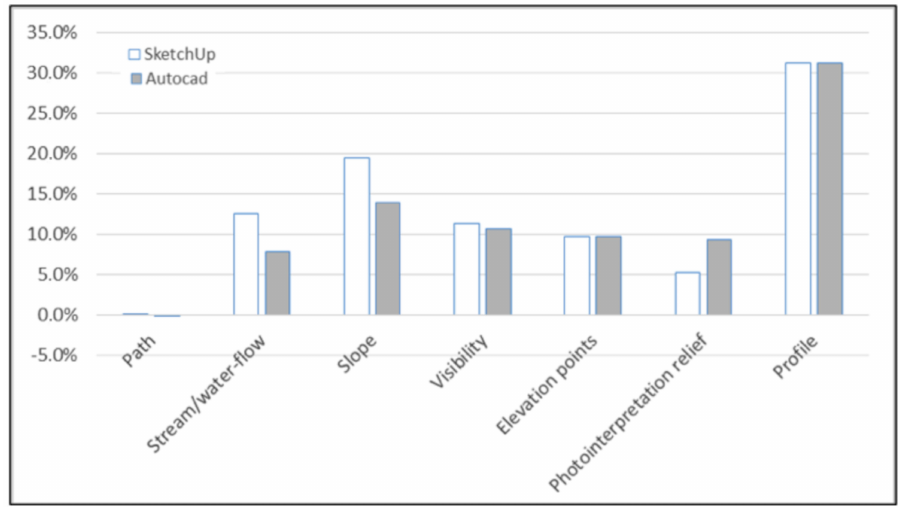
Figure 5. Gains by group: percentage of the highest possible